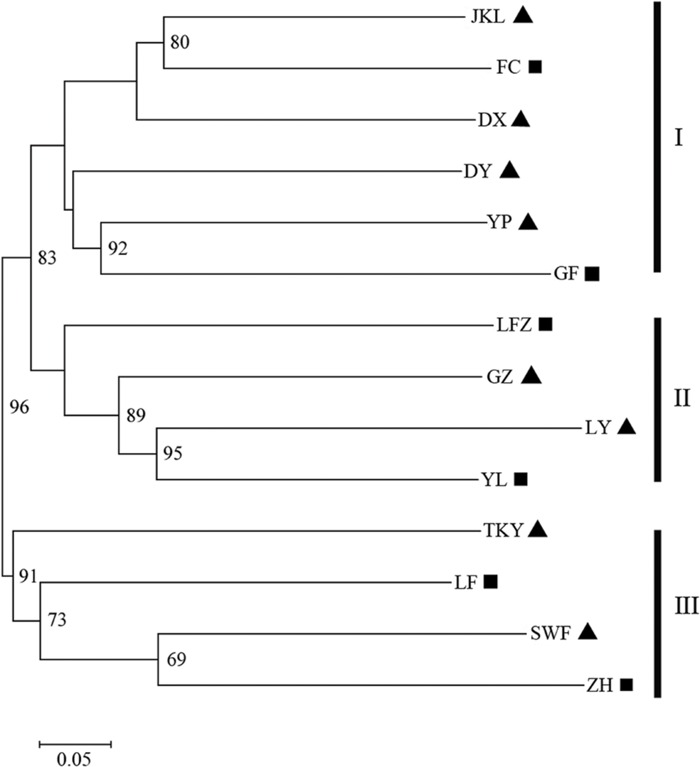
The Neighbor-joining (NJ) tree of C. communis accessions based on Cavalli-Sforza’s chord distance. Number at nodes represent the frequency (expressed as a percentage) at which a node occurred among 10, 000 replications. Bootstrap values higher than 60% from 1000 replicates are shown above the branches. The abbreviations of population name are same as Table 1.